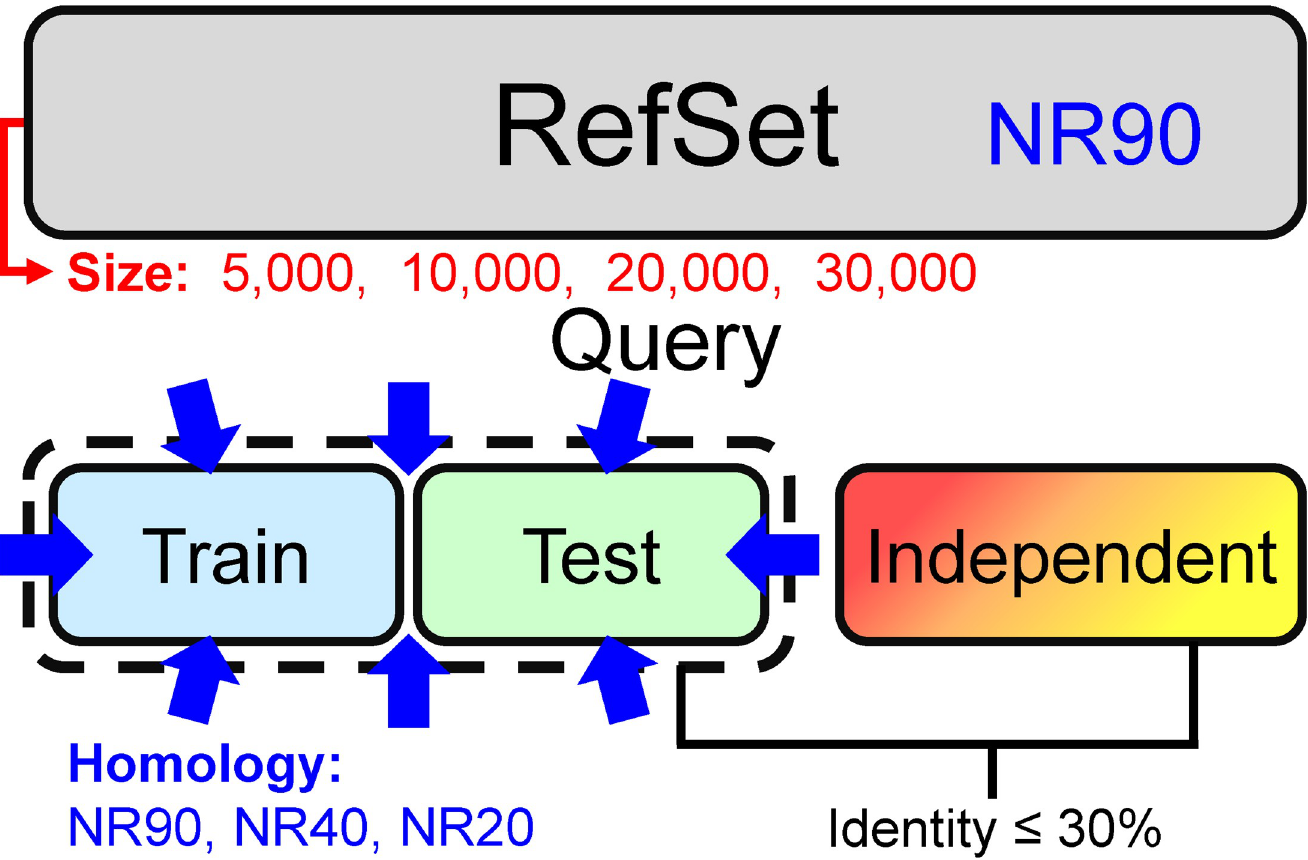
Fig 13. Experimental design for measuring SSP accuracy under different reference dataset sizes. The focus of this experiment was to determine the influence of the reference dataset size on SSP accuracy. The maximum size was 30,000 proteins because the source of the reference sequences, i . e ., NrPdb90-2015, contained only 34,533 proteins. The sequence identity of training and testing query sequences was also adjusted to see whether the reference dataset size’s influence would be affected.